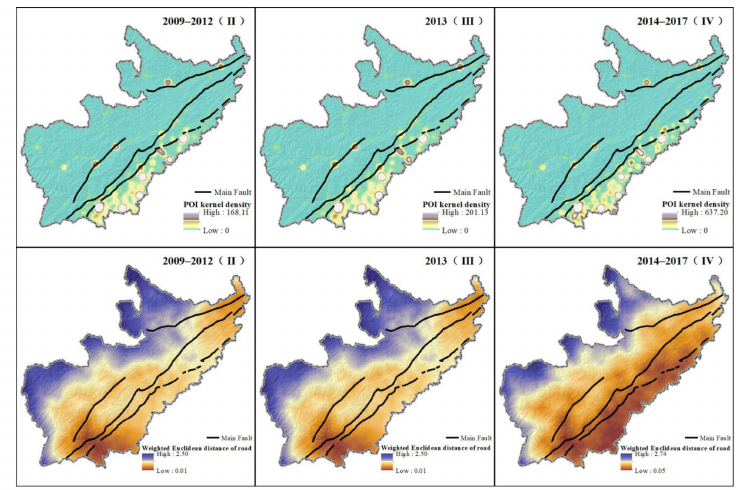
Figure A2. Thematic maps of dynamic factor in other